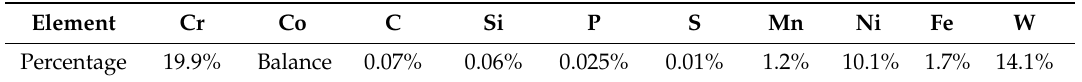
Table 1. Chemical composition of CoCr tubes.